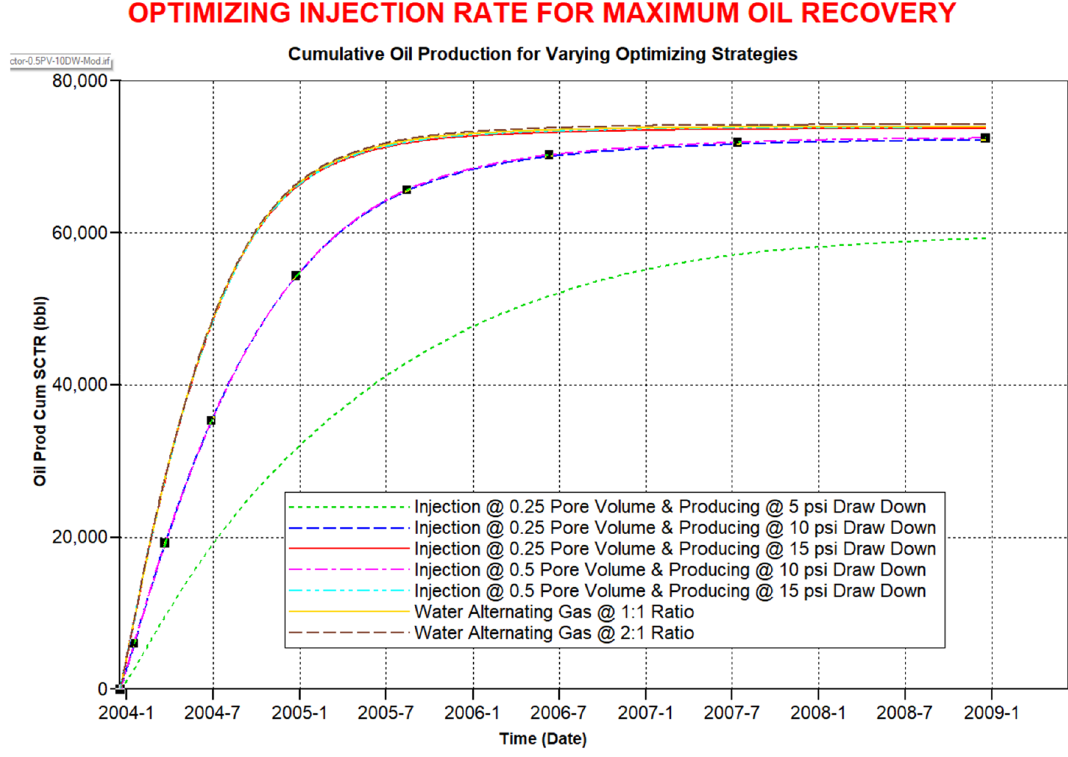
Fig. 9 Cumulative oil production response for varying optimization